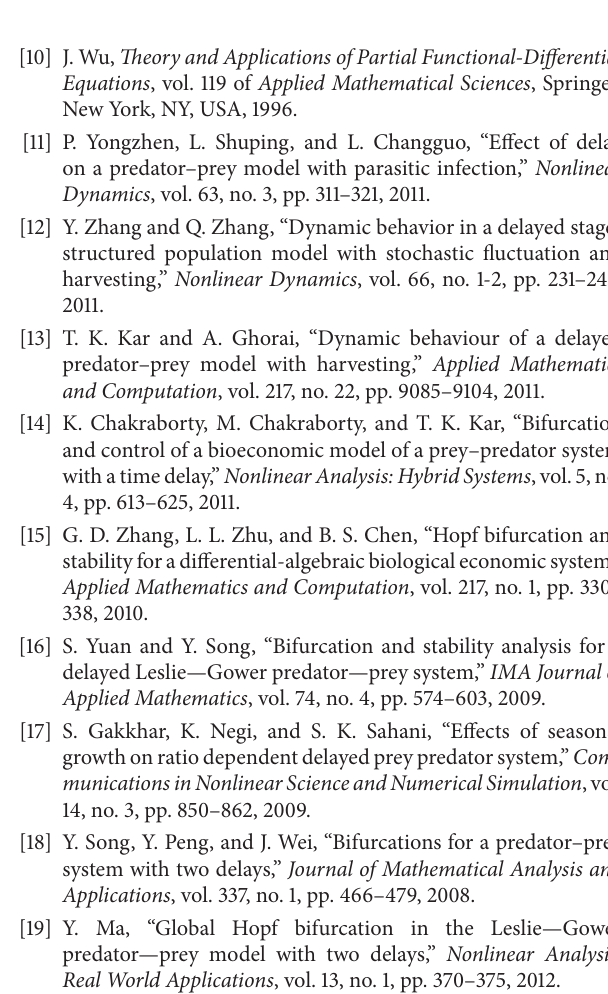
Figure 6: The projection of the attracting set of model (1) in the 𝑥 - 𝑦 plane for (a) 𝜏 1 = 1.01 , (b) 𝜏 1 = 1.0125 , and (c) 𝜏 1 = 1.017 ,